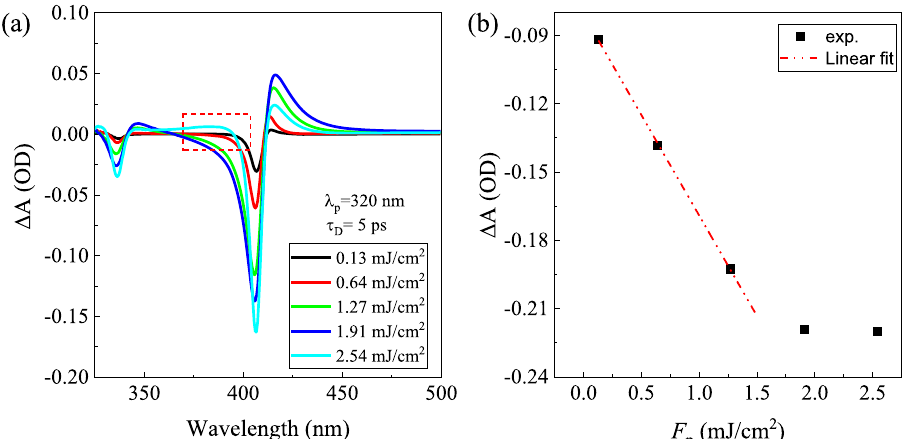
Fig.6|DependenceofTAspectraonpump fl uence.a TAspectraofCuI fi lmunderdifferent F p ( λ p =320nm)atatimedelayof5ps. b Themaximumof Δ Avs F p monitored at